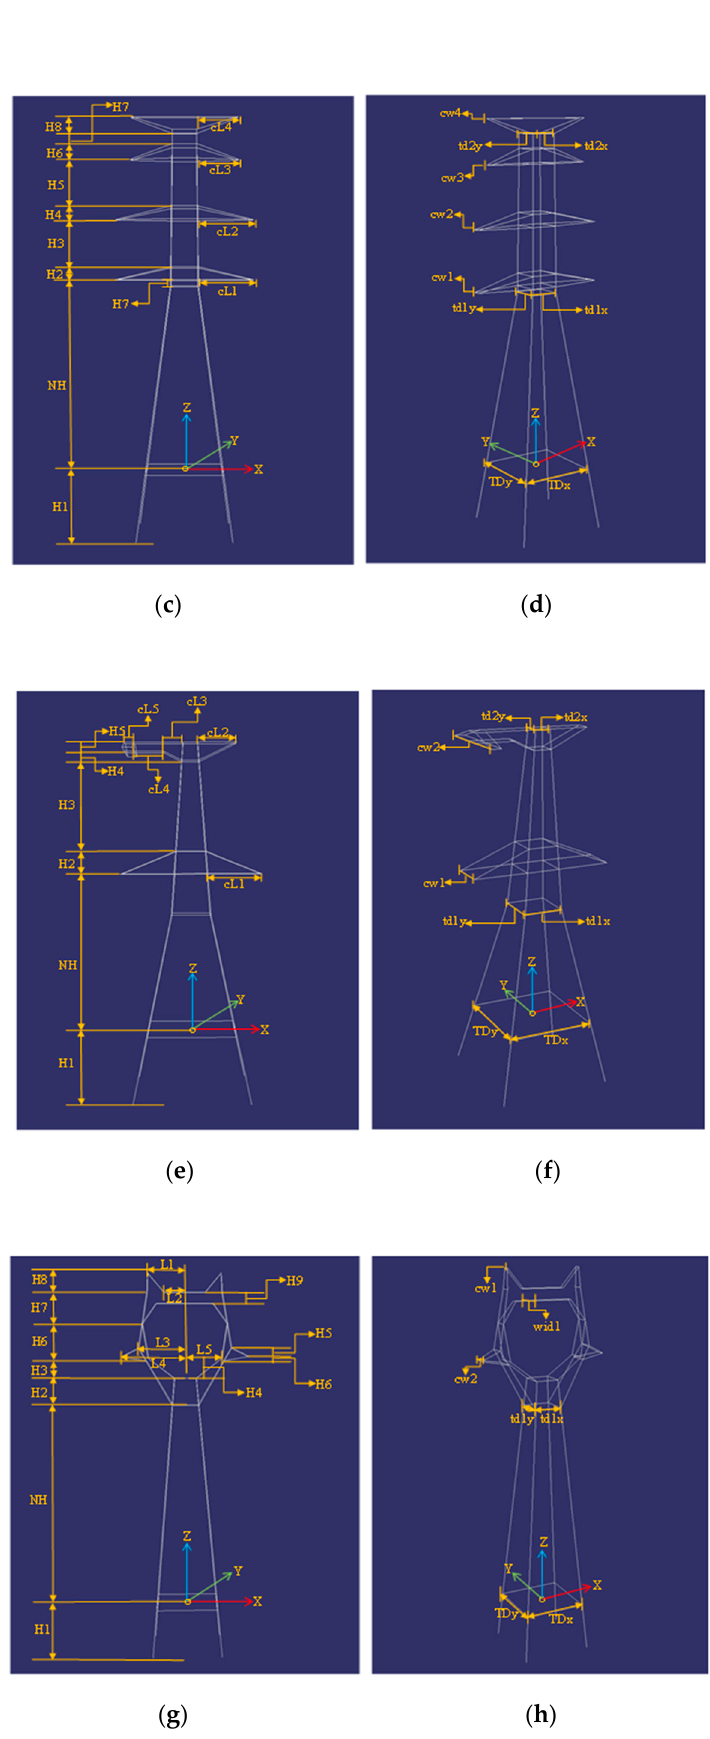
Figure 3. Pylon model library. ( a , b ) The M 1 model with di ff erent views; ( c , d ) the model M 2 with di ff erent views; ( e , f ) the M 3 model with di ff erent views; ( g , h ) the M 4 model with di ff erent views.